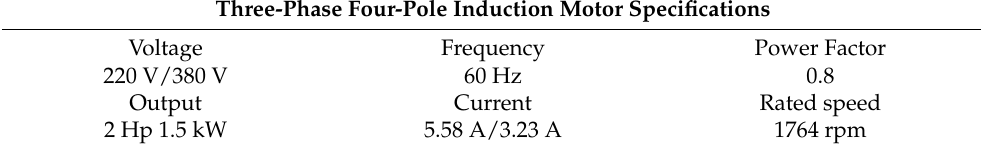
Figure 5. Torque sensor, servo motor, computer, oscilloscope, and data miner (NI PXI-1033).